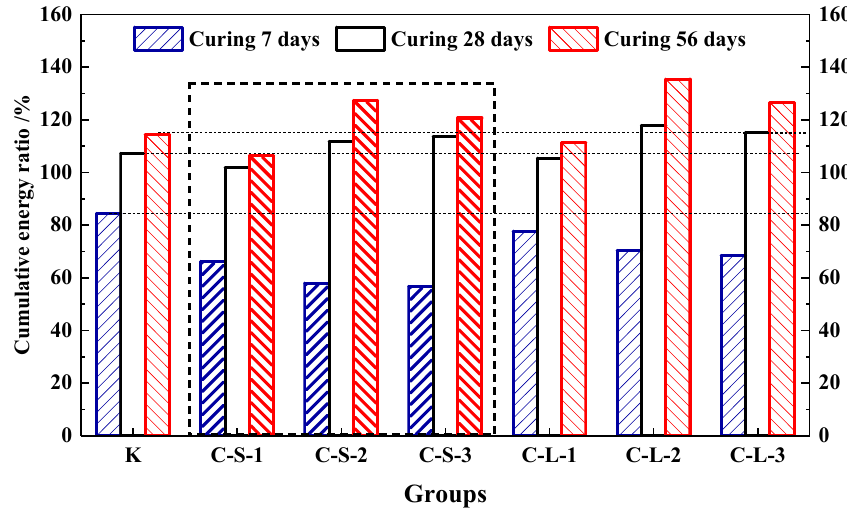
Figure 20. Cumulative energy ratio of mortar.